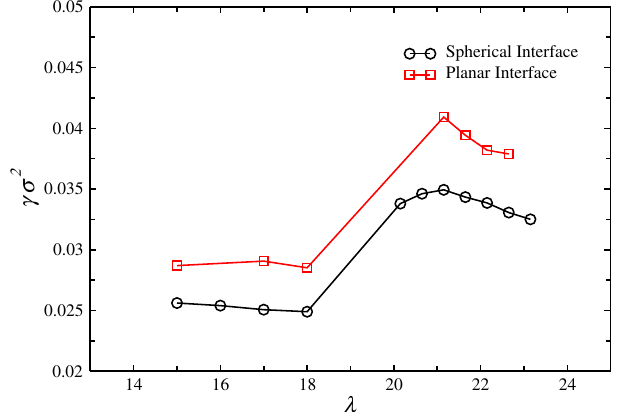
FIG. 11. Interface tension γσ 2 . Comparison between the inter- face tension computed from the free-energy cost of forming a planar interface at coexistence (red squares) and the classical nucleation theory fit to the free-energy cost of forming spherical nuclei at β Δ μ ¼ 0 . 6 (black circles).